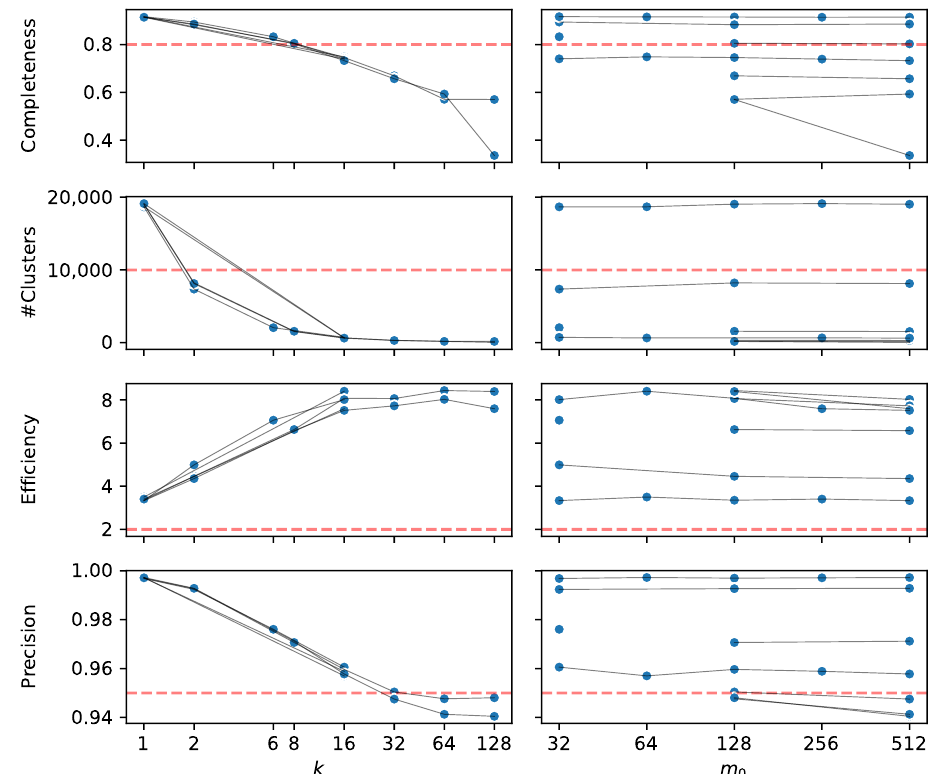
Figure A7. HDBSCAN*: Dependency of efficiency, completeness, number of resulting clusters and sorting precision on neighborhood size k and initial cluster size m 0 . Each dot is an experiment with an individual hyperparameter configuration. In each plot, gray lines connect the dots that share the same hyperparameter configuration apart from the parameter that is varied in each column. k and m 0 are on a logarithmic